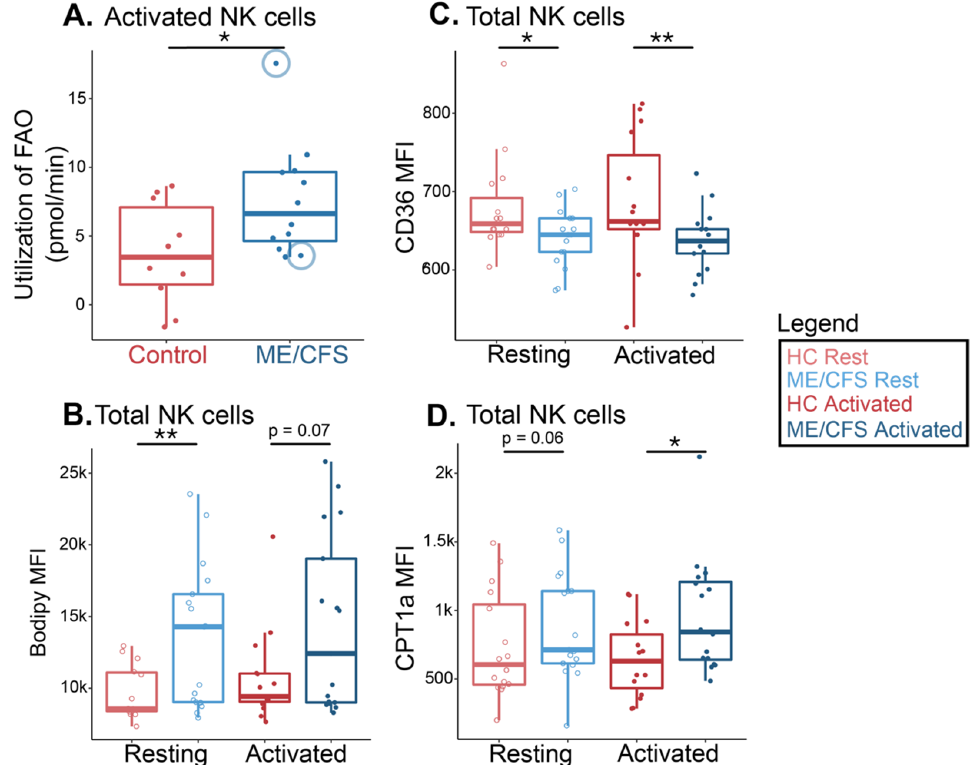
Figure 4. ME/CFS NK cells increased fatty acid oxidation compared to healthy controls. ( A ) Fatty acid oxidation measurements from a Seahorse extracellular flux analysis of stimulated NK cells ( n = 10 healthy control samples; n = 12 ME/CFS samples). Each dot represents the change in oxygen consumption rate (pmol/min) under high energy demands following the injection of a fatty acid oxidation inhibitor (etomoxir) in one sample, with an average of 2–3 technical replicates. The blue circles around two of the data points indicate one patient at two different time points ( B ) Mean fluorescence intensity of a supplied fatty acid (Bodipy) in resting and activated NK cells ( n = 14 healthy control samples at rest; n = 17 ME/CFS samples at rest; n = 15 healthy control samples after activation; n = 17 ME/CFS samples after activation, [ n = 14/17/15/17]). ( C ) Median fluorescence intensity of a fatty acid cell membrane transporter, CD36, in resting and activated NK cells ( n = 15/17/15/17). ( D ) Median fluorescence intensity of a fatty acid mitochondrial transporter, CPT1a, in resting and activated NK cells ( n = 16/17/15/16). Box plots represent the median ± 25th and 75th quartiles. Whiskers represent 1.5× the interquartile ranges. Outliers are values outside the whisker range. Healthy control and ME/CFS data points are light (resting) or dark (activated) red or blue, respectively. For Seahorse data, * p < 0.05 by Wilcoxon rank-sum test. For flow cytometry data, * p < 0.05, ** p < 0.01 by Kruskal–Wallis followed by Dunn’s test with FDR-based multiple testing correction.